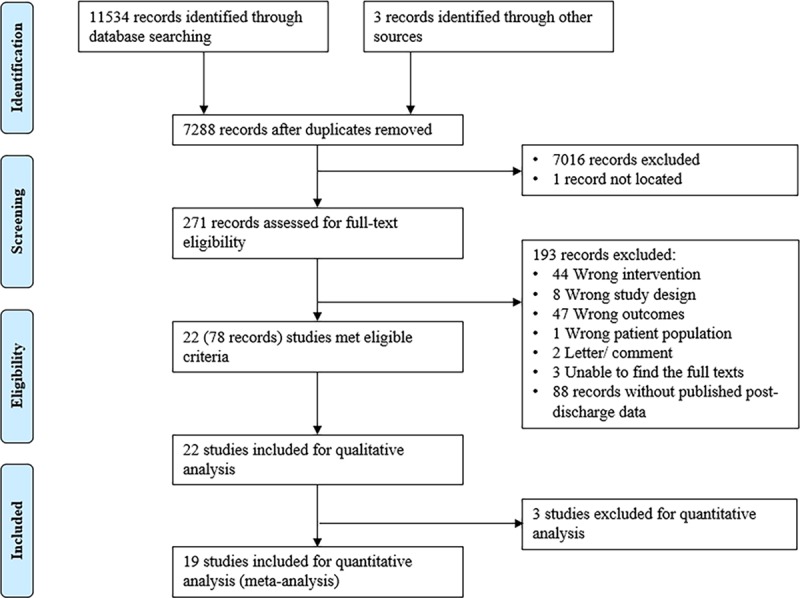
Flow diagram for included studies.